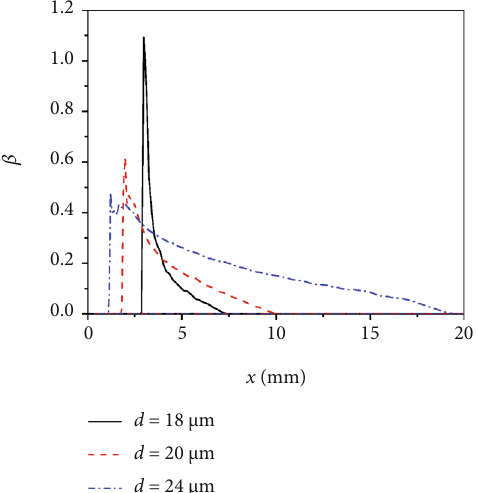
Figure 13: Collection e ffi ciency for the engine cone section at various droplet